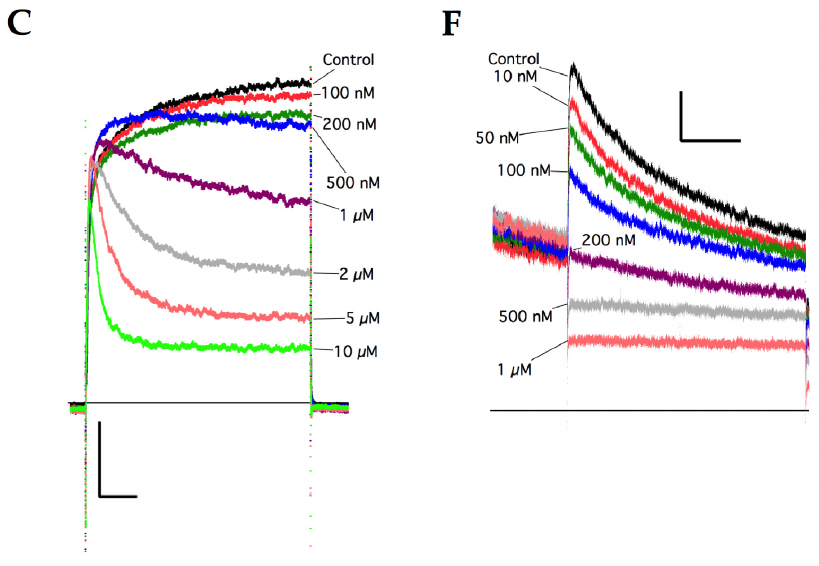
Figure 12. ( A ) Dose–response curves of compounds 1 and 8 for K V 1.10 inhibition. The red trace has been included as reference and corresponds to ZVS-08 (from Figure 9B). The IC 50 values from the fit were 740 nM (95% CI 490 nM to 1.17 µ M, N = 7–9) for compound 1 and 1.01 µ M (95% CI: 796 nM to 1.30 µ M, N = 4–7) for compound 8 . ( B ) Representative Kv10.1 current traces obtained in the presence of different concentrations of Compound 1 . Scale bars: 1 nA, 50 ms. The cell was depolarized to +40 mV for 500 ms. No leak subtraction was performed. ( C ) Representative traces obtained in the presence of different concentrations of Compound 8 . Scale bars: 1 nA, 50 ms. ( D ) Dose–response curves of compounds ZVS-08, 1 and 8 for hERG inhibition. The IC 50 values from the fit were 0.194 µ M (95% CI 0.047 µ M to 0.761 µ M, N = 2–7) for ZVS-08, 0.207 µ M (95% CI 0.113 µ M to 0.395 µ M, N = 3–8) for compound 1 and 0.156 µ M (95% CI: 0.070 µ M to 0.373 µ M, N = 3–8) for compound 8. ( E ) Representative traces of hERG currents obtained in the presence of different concentrations of Compound 1 . Scale bars: 150 pA, 1 s. Only the end of the response at +20 mV and the tail current at − 40 mV are represented. ( F ) Representative traces obtained in the presence of different concentrations of Compound 8 . Scale bars: 150 pA, 1